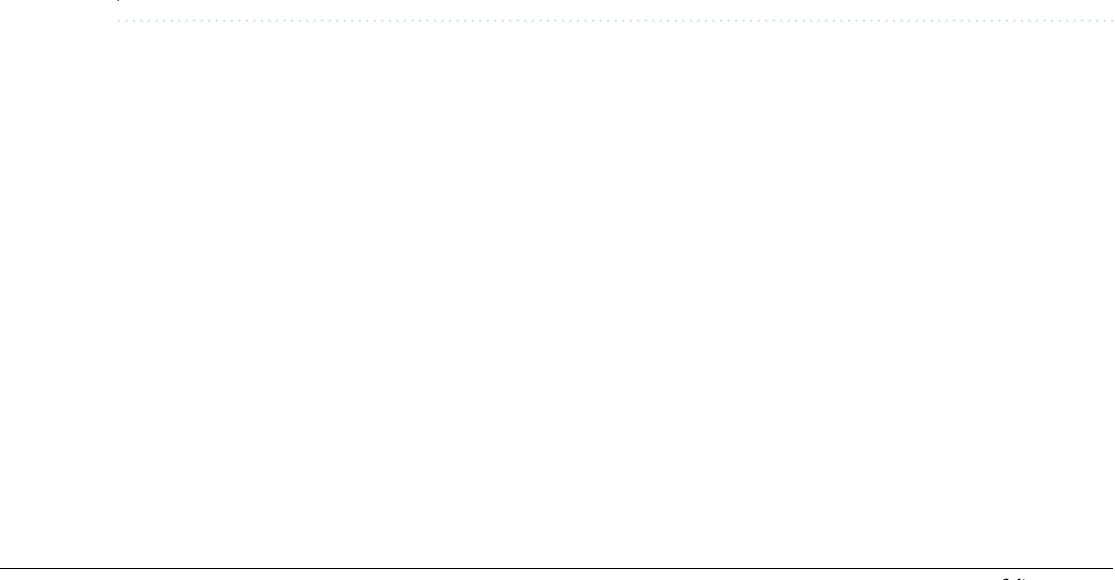
Figure 10. The case’s chaotic attractor dynamics, shown in 2D and 3D phase portraits when β = 1 (line) and β = 0.95